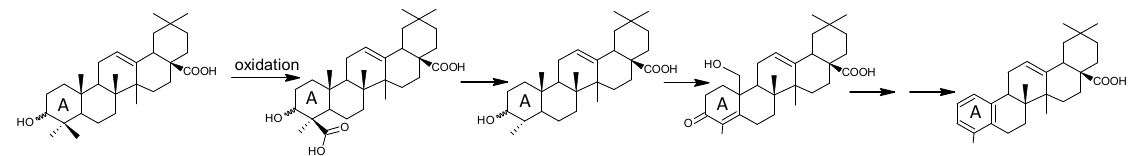
Figure 7. Possible oxidation route of oleanonic acid, a typical triterpenic mastic component leading to aromatic product (formation of aromatic ring A).